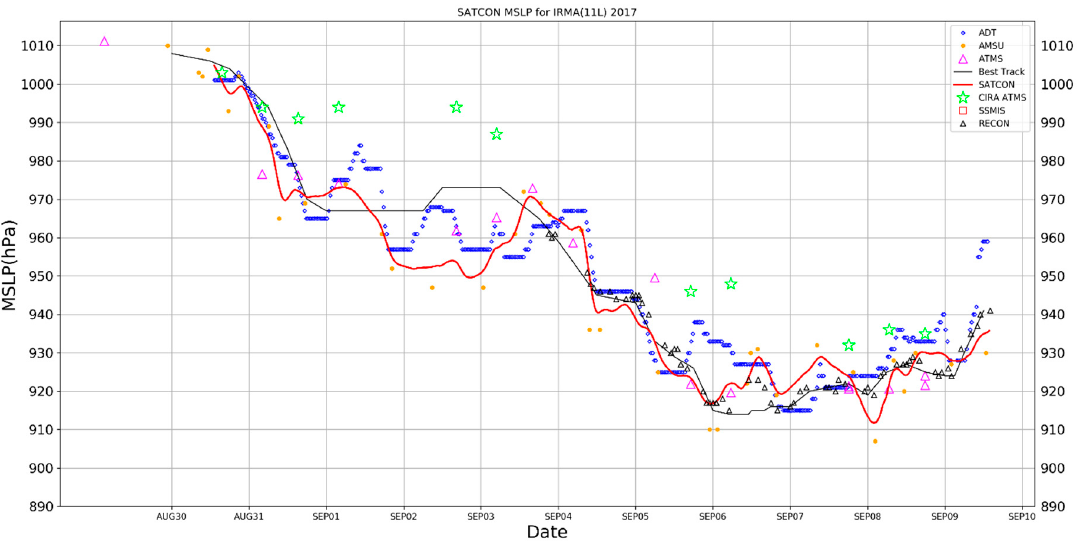
Figure 5. Real-time CIMSS tropical cyclone SATCON minimum sea-level pressure (MSLP, hPa) estimates at 30 min intervals (red line) from 0000 UTC 30 August 2017 to 1200 UTC 9 September for Hurricane Irma that incorporate various satellite instruments (see inset in upper right) and include the aircraft recon observations (small, black triangles) and the six-hourly NHC working best-track intensity estimates digitized to 5 kt increments (thin black